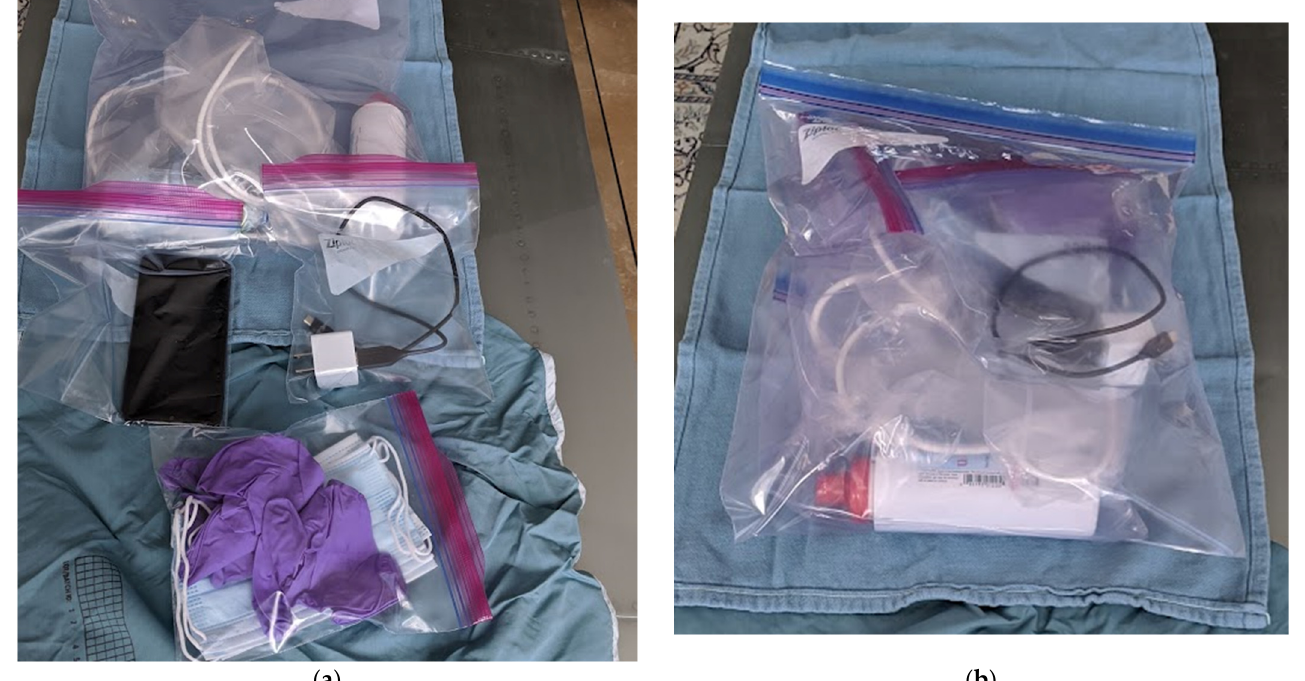
Figure 3. ( a ) Sanitized Home Ultrasound Delivery Package. Legendz: Sanitized package for home-delivery to patients containing a Philips Lumify Ultrasound probe and dedicated smart phone to support the ultrasound, gloves, masks, and ultrasound jelly. ( b ) Sanitized Home Ultrasound Delivery Package. Figure Legend: Sanitized package ready for home-delivery to self-isolating patients.